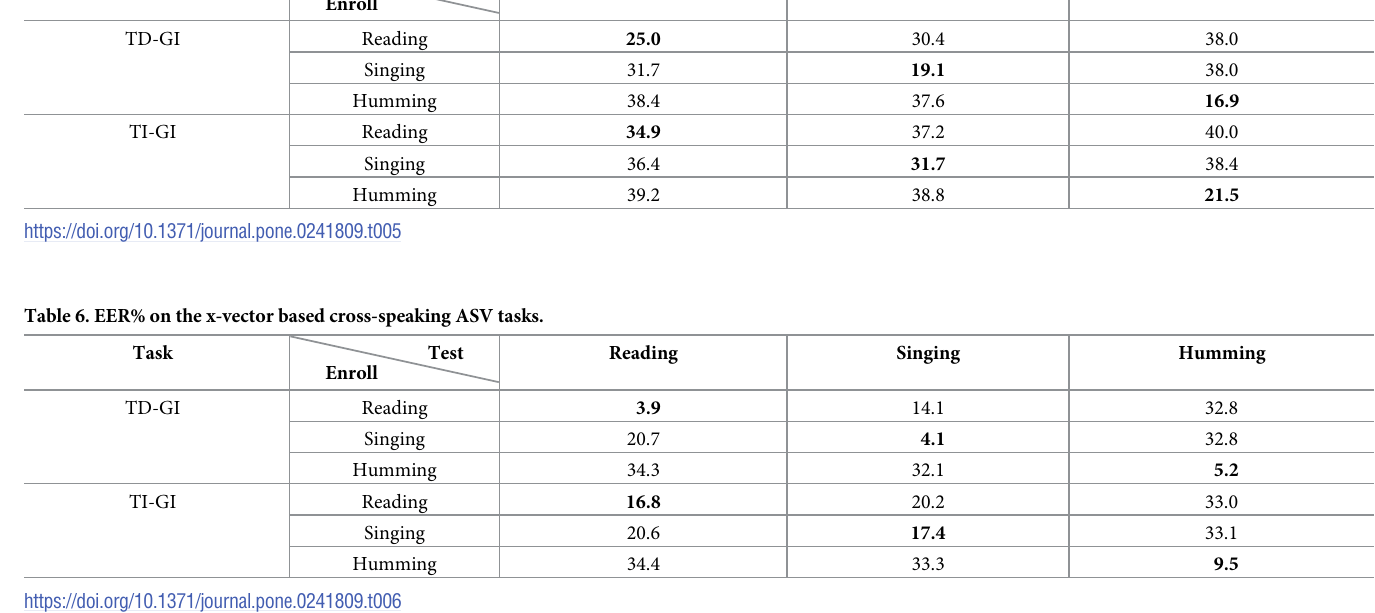
Table 5. EER% on the GMM-based cross-speaking ASV tasks. Task